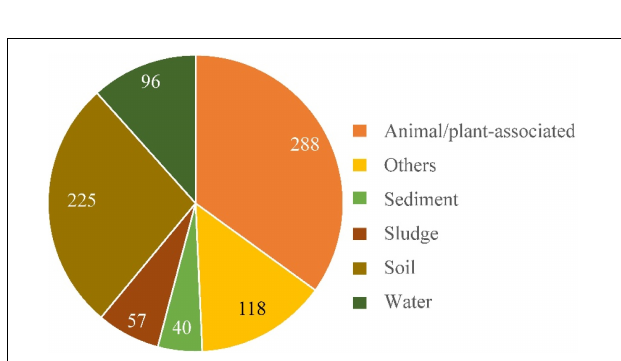
FIGURE 6 | Distribution of the genus Alcaligenes in nature. Categories of samples and numbers of Alcaligenes 16S rRNA gene sequences are indicated. The results were based on the analysis of 16S rRNA gene sequences defined in GenBank of NCBI database.